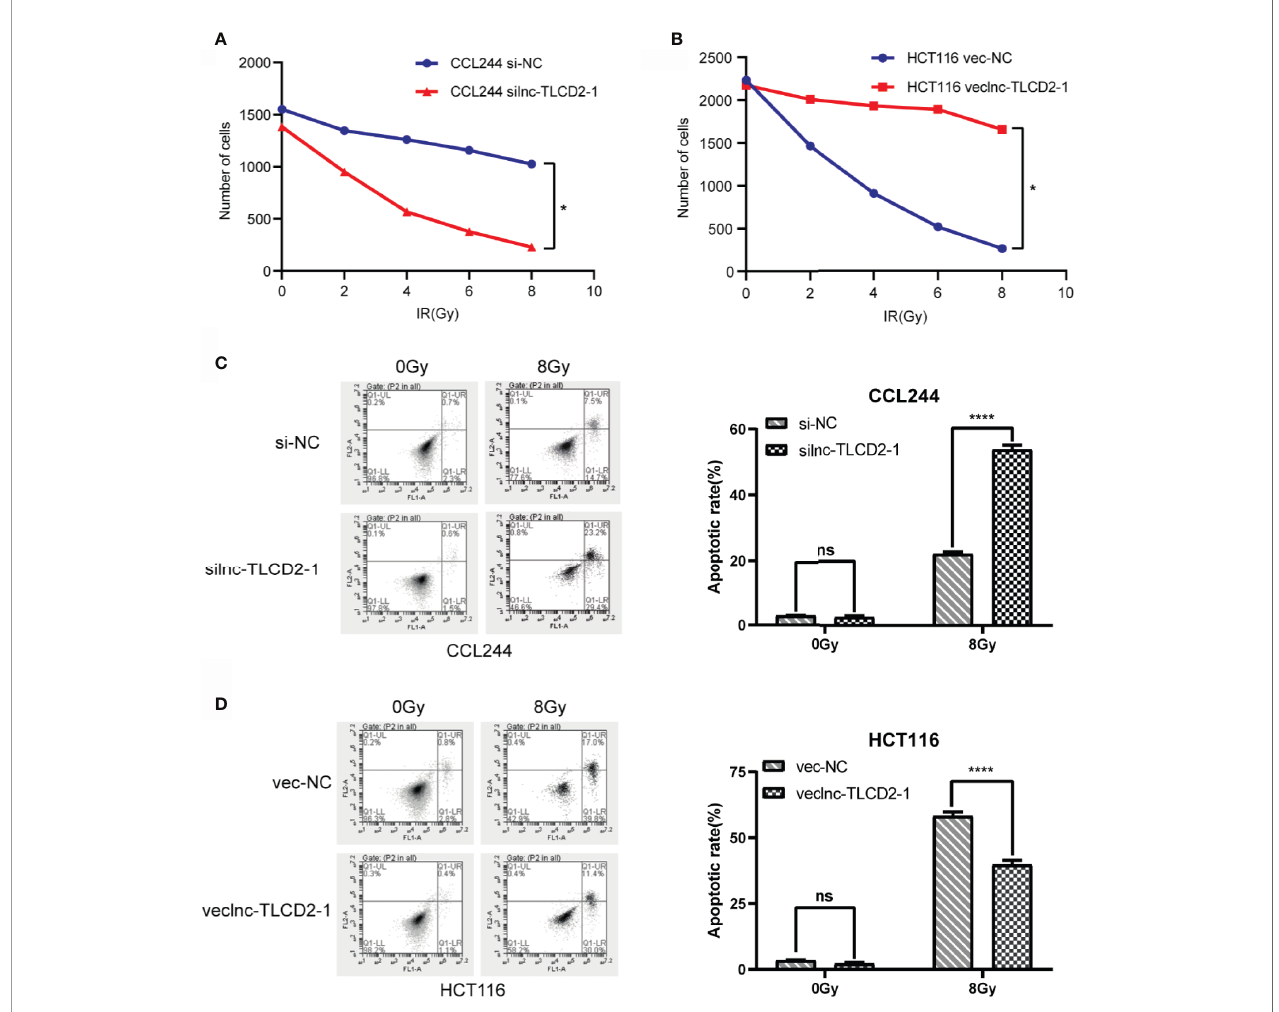
FIGURE 3 | The effect of lnc-TLCD2-1 on radiation resistance of CRC was investigated by cell cloning assay and fl ow cytometry. (A) After inhibition of lnc-TLCD2-1 in CCL244, the number of cells decreased sharply with the increase of radiation intensity. (B) After upregulating the expression of lnc-TLCD2-1 in HCT116, the number of cells decreased with the increase of radiation. (C) Flow cytometry disclosed that the apoptosis rate of CCL244 with interference of lnc-TLCD2-1 was signi fi cantly increased after radiation. (D) Flow cytometry revealed that the apoptosis rate of HCT116 with upregulated of lnc-TLCD2-1 was signi fi cantly decreased after radiation. (P<=0.05 means statistically signi fi cant, ns, no signi fi cance, *p < 0.05, ****p <